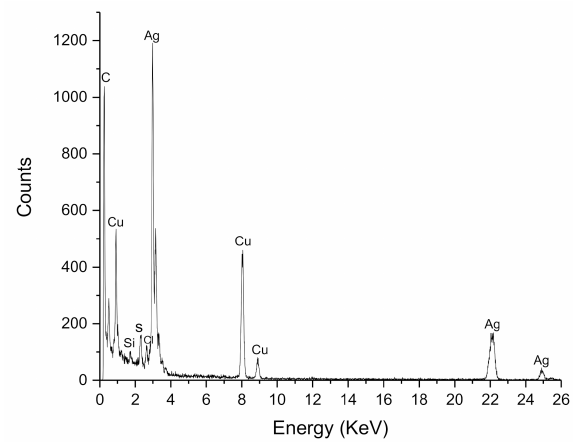
Figure 4. EDX spectrum of AgNPs synthetized by pecan nut shell extract.